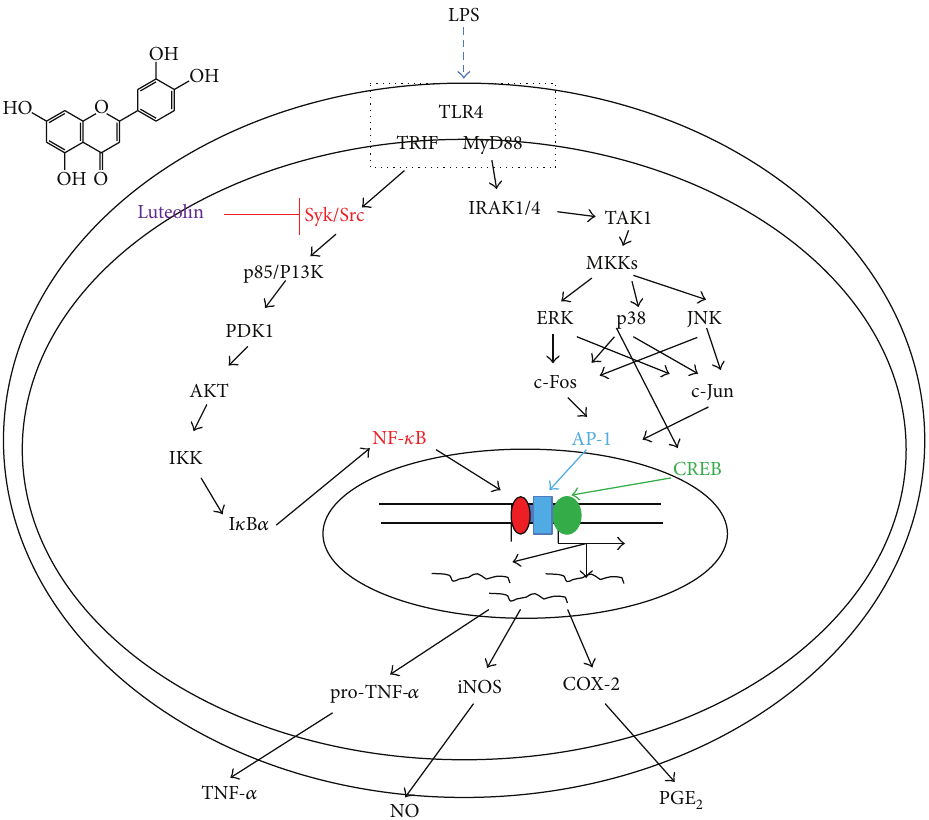
Figure 5: Putative mechanism of inhibition of macrophage-mediated inflammatory signaling events by